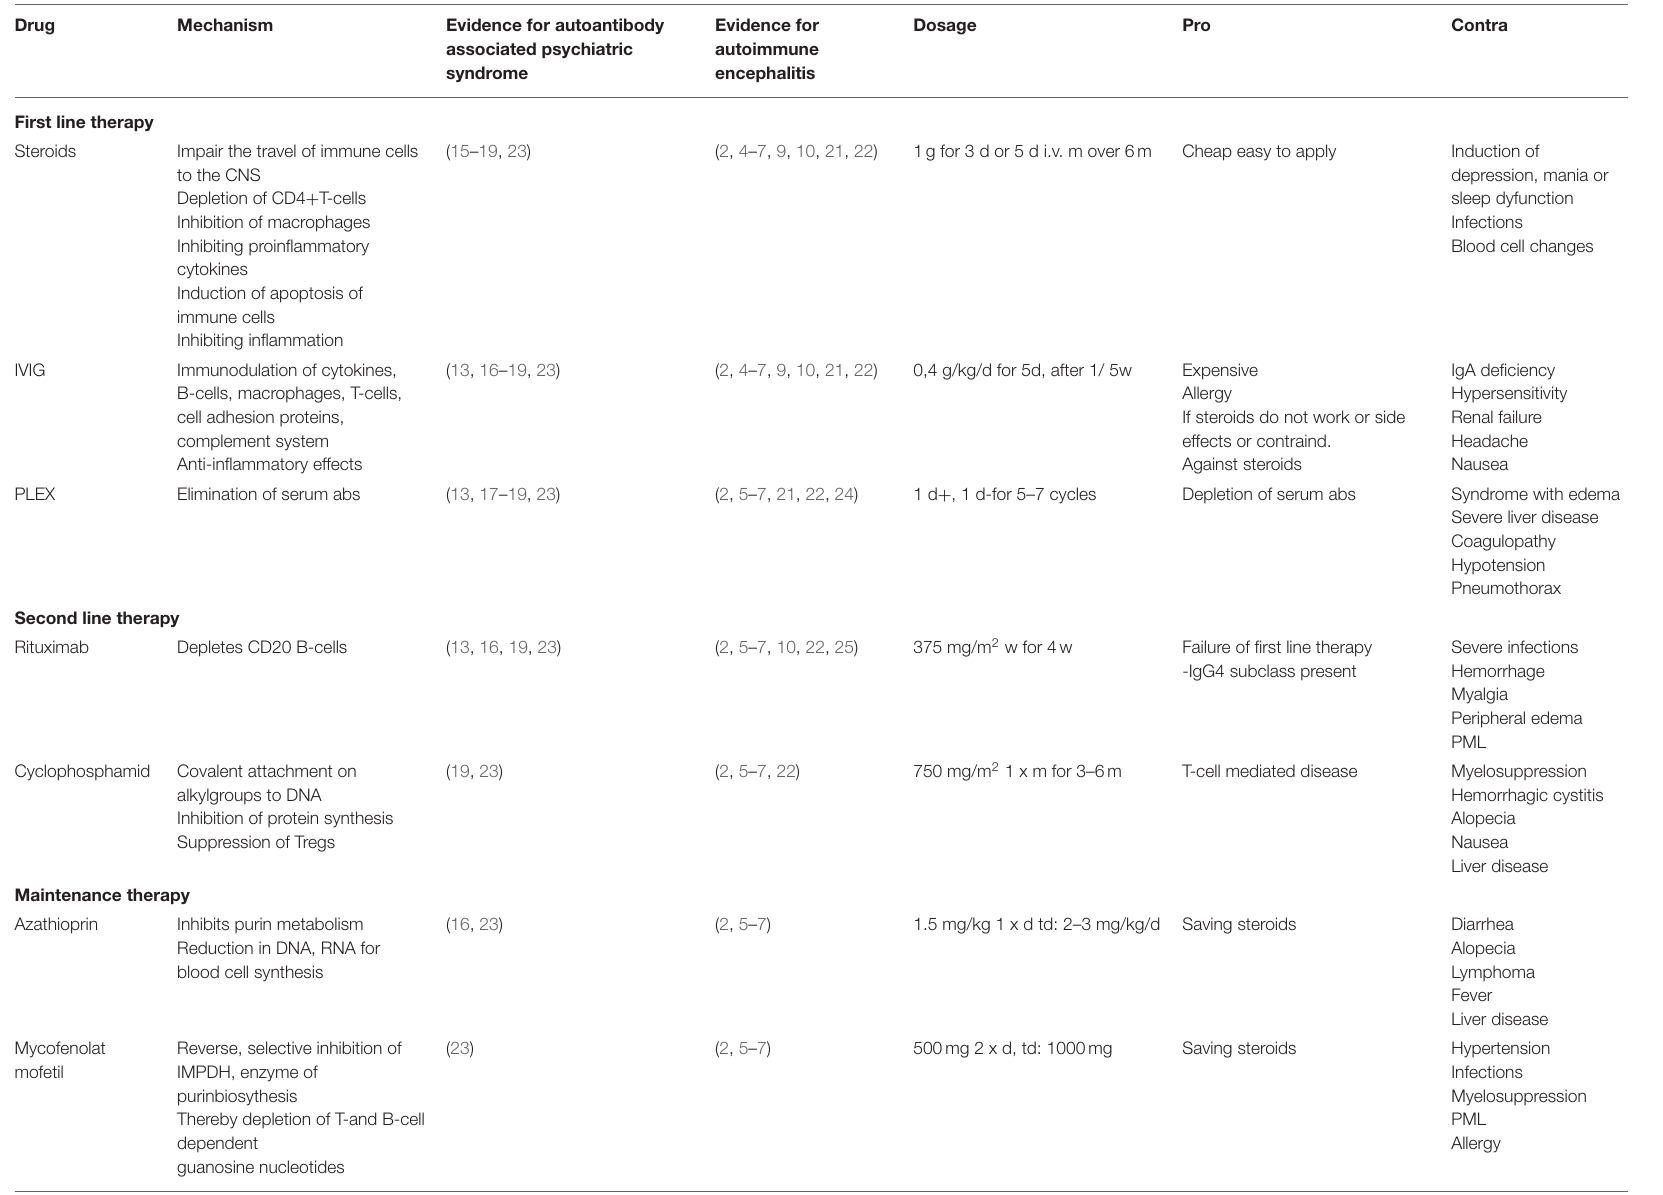
TABLE 1 | Immunotherapy in autoimmune encephalitis and autoimmune-based psychiatric